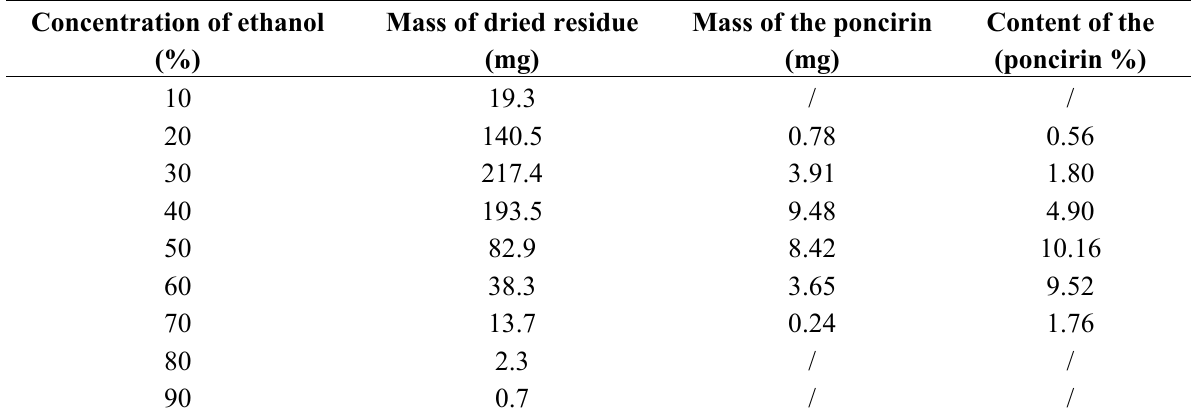
Table 2. Results of gradient elution of the poncirin on column packed with D101 resin. Concentration of ethanol Mass of dried residue (%)